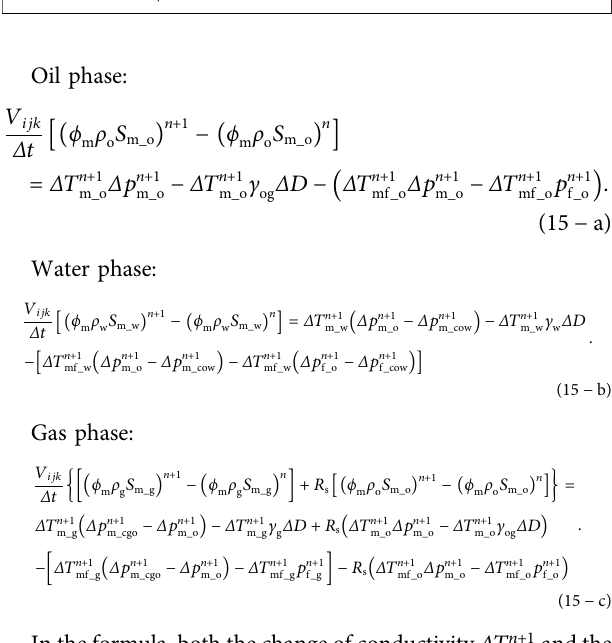
FIGURE 5 | The schematic diagram of the ESPIDO algorithm for dealing with the bordered